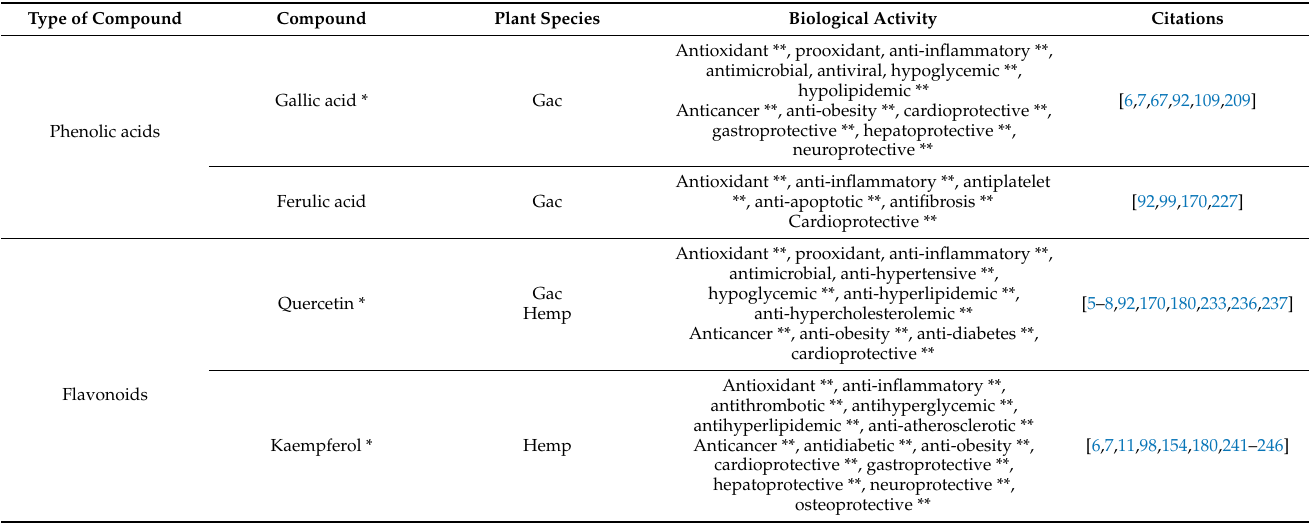
Table 2. Compounds isolated from seeds usually eaten separately from fruits and their biological